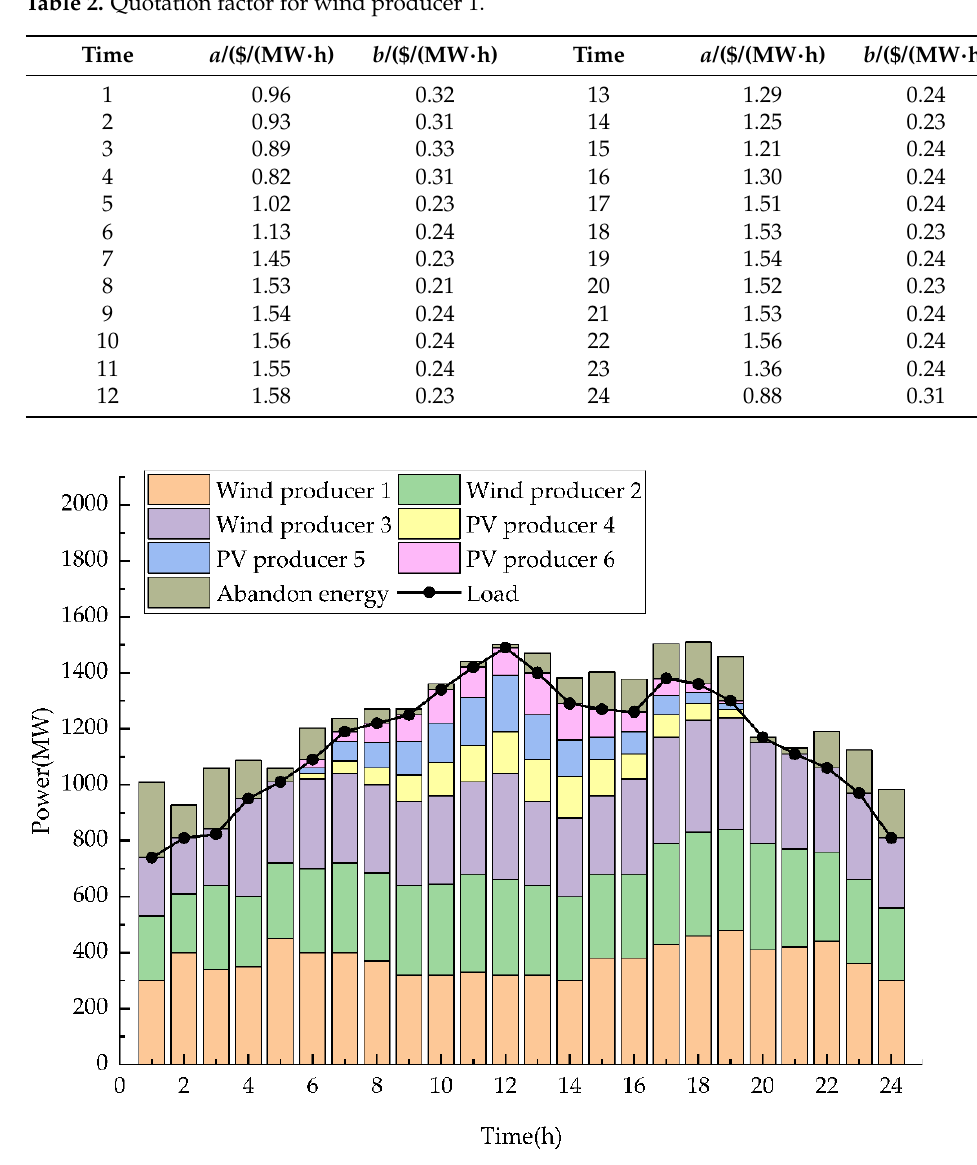
Figure 5. Output of each producer after first clearing.